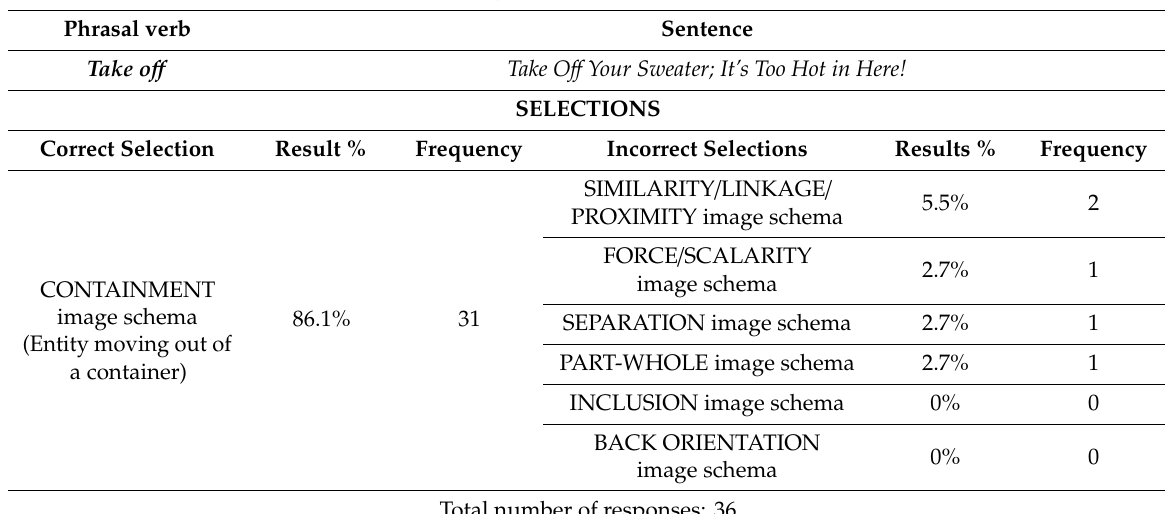
Table 9. Frequencies for take o ff